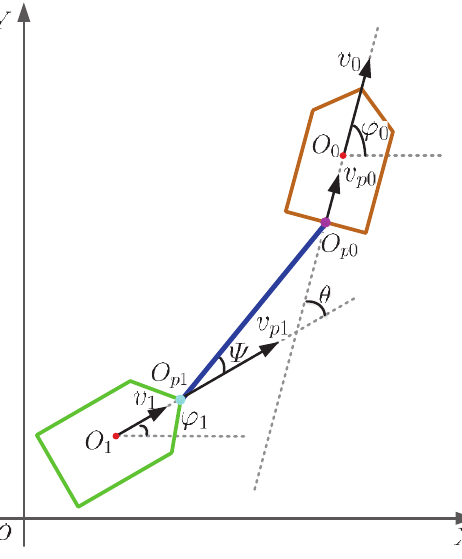
Figure 1. Model of a ship towing